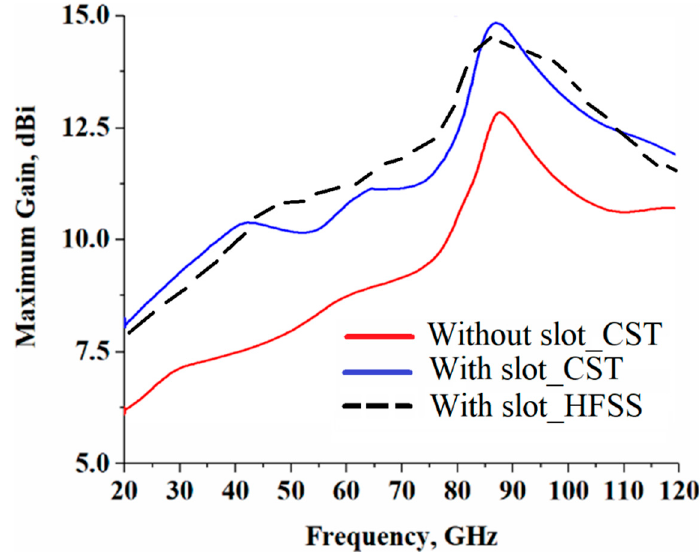
Figure 4. Gain response for both cases “with no” slots and “with” slots using two different commercially available 3D full wave electromagnetics simulation tools (CST Microwave Studio ® and HFSS™).